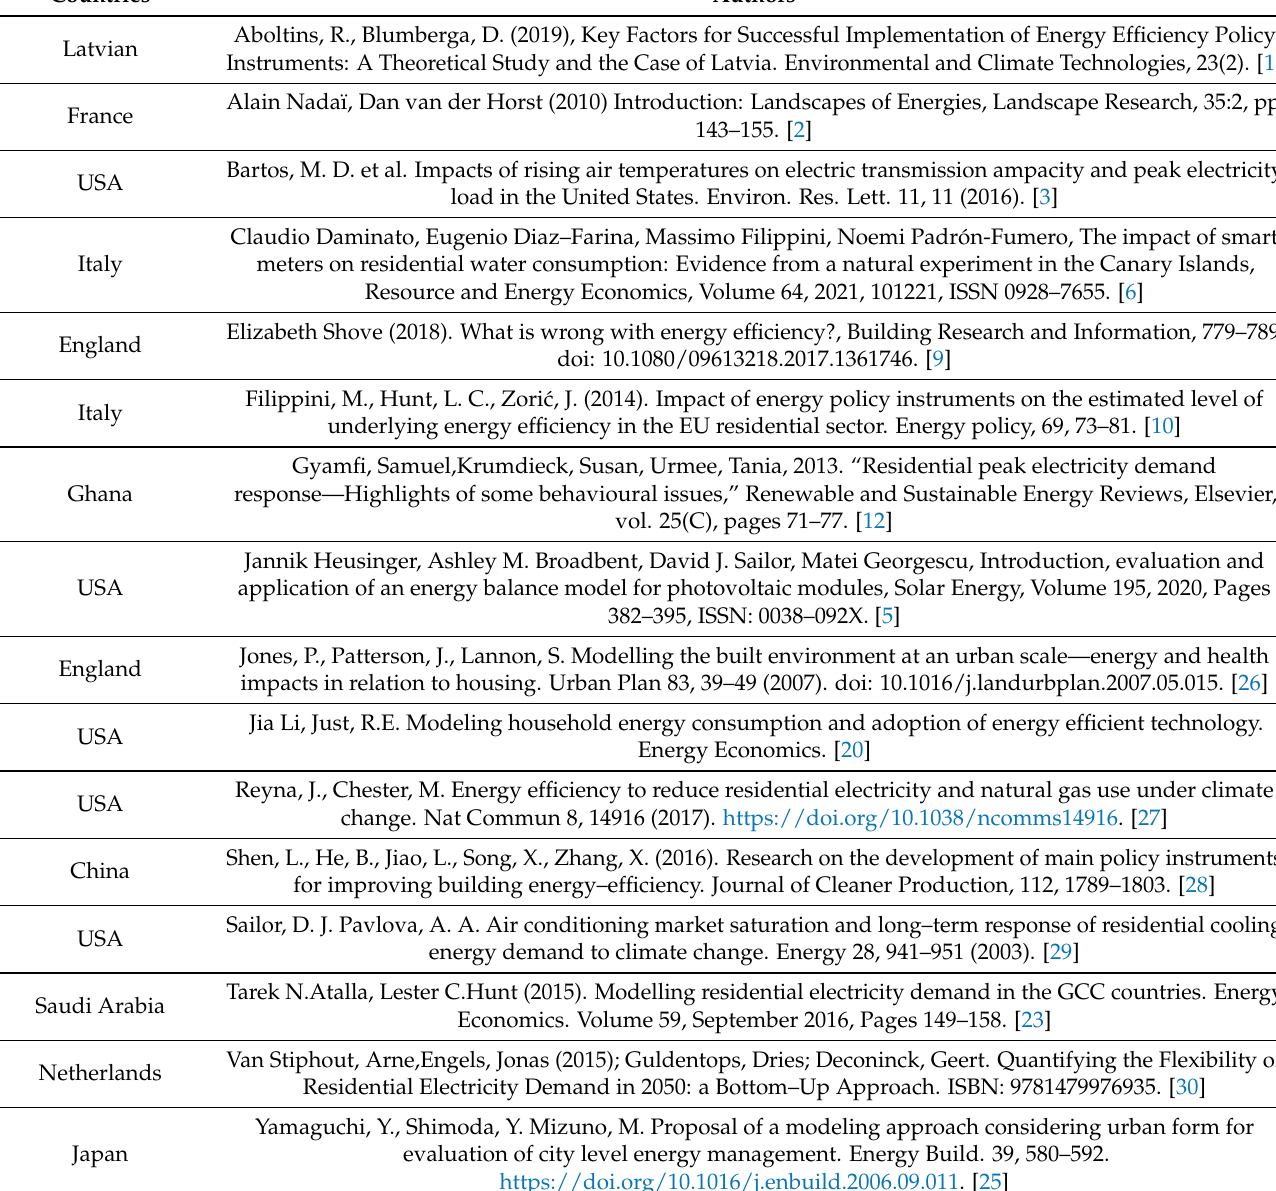
Table 1. Research in the field of energy supply by country. Note: developed by the